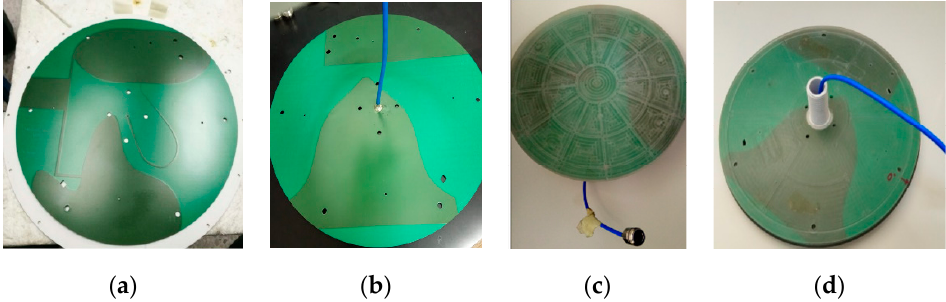
Figure 22. The photo of PCB with green mask ( a ) Top View and ( b ) Back View. The picture of the prototype with a transparent radome and cable assembly ( c ) Top View and ( d ) Back View.